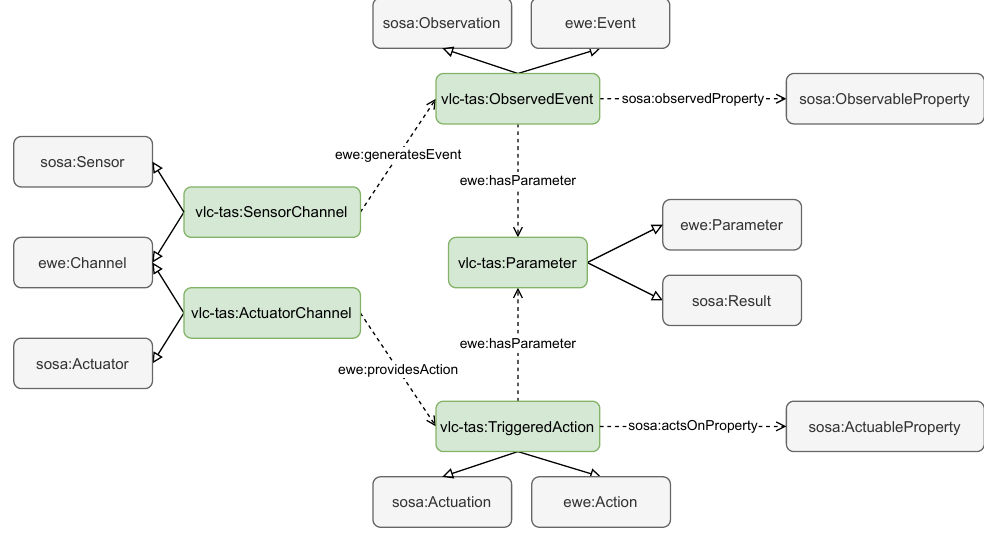
Figure 3. Semantic model